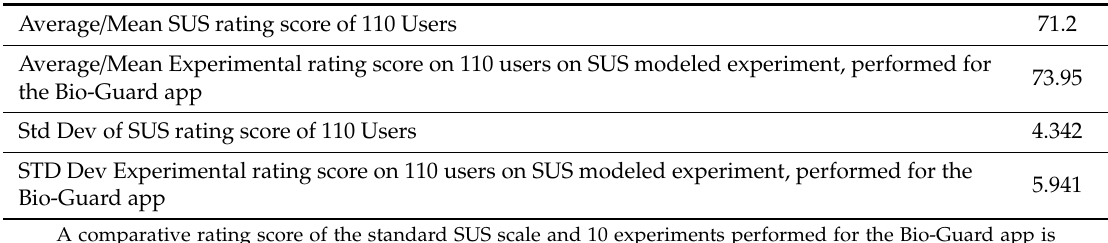
Table 3. A comparative score of the standard SUS Scale and 10 experiments.